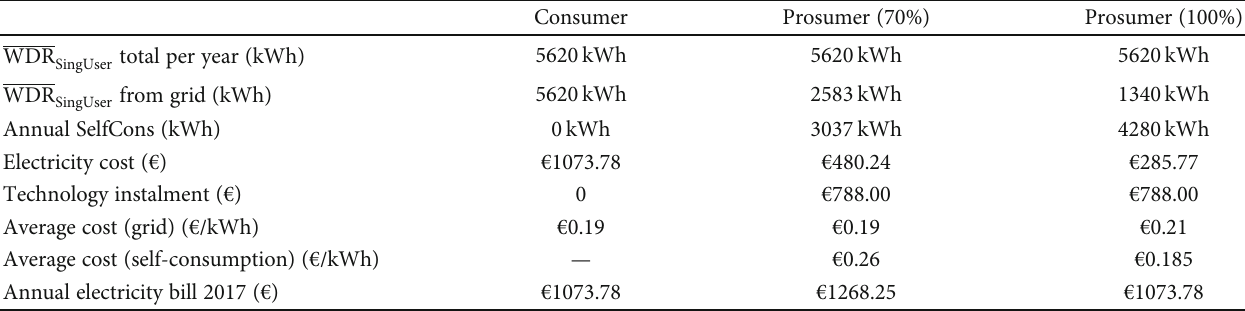
Table 12: The annual electricity bill in terms of electricity self-consumption percentage.